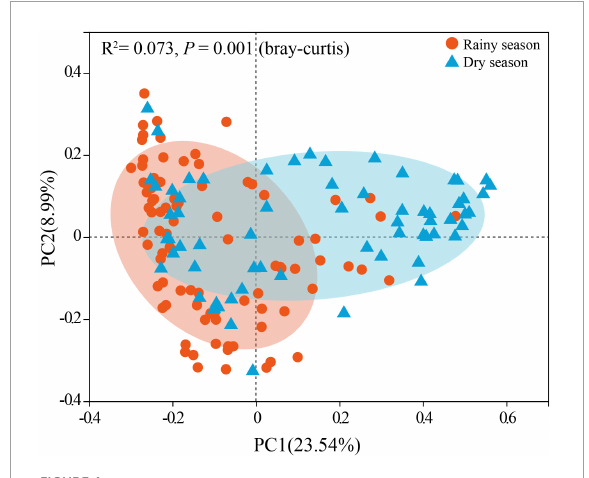
FIGURE4 Seasonal comparison of gut microbiota beta diversity based on OTUs (Tested by